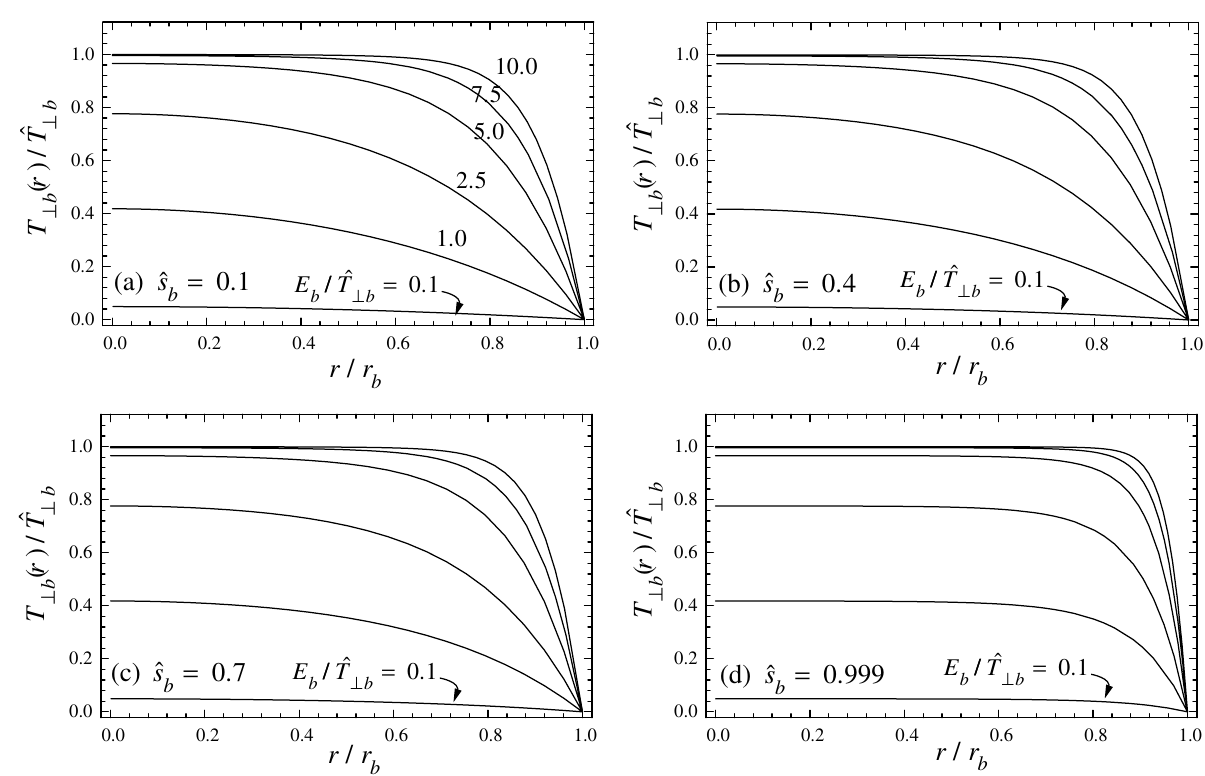
(cid:1) r (cid:3) = ^ TT r=r obtained from Eqs. (8) and (10) for (a) ^ ss ? b versus b b = ^ TT )=) identical to those in Fig. 3. ? b and b 0